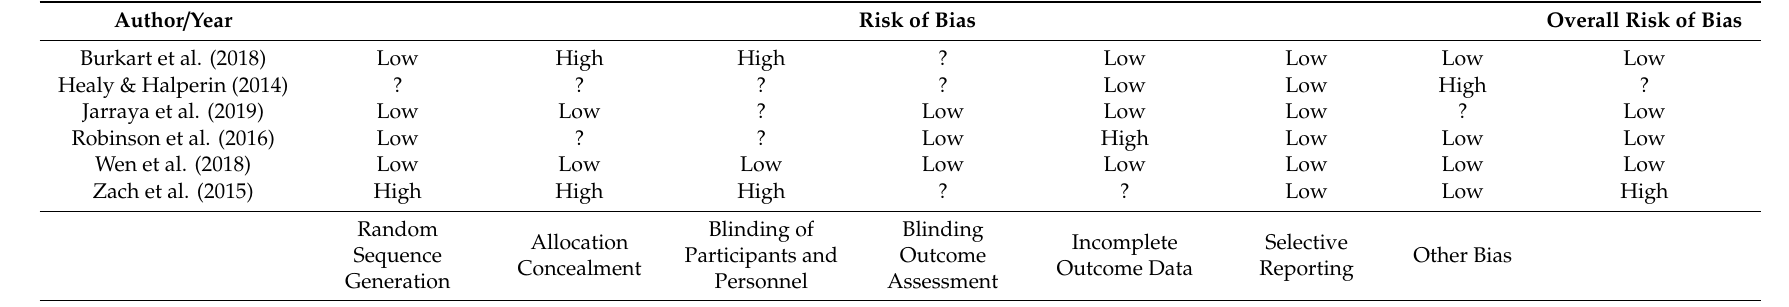
Table 2. Risk of Bias Assessment